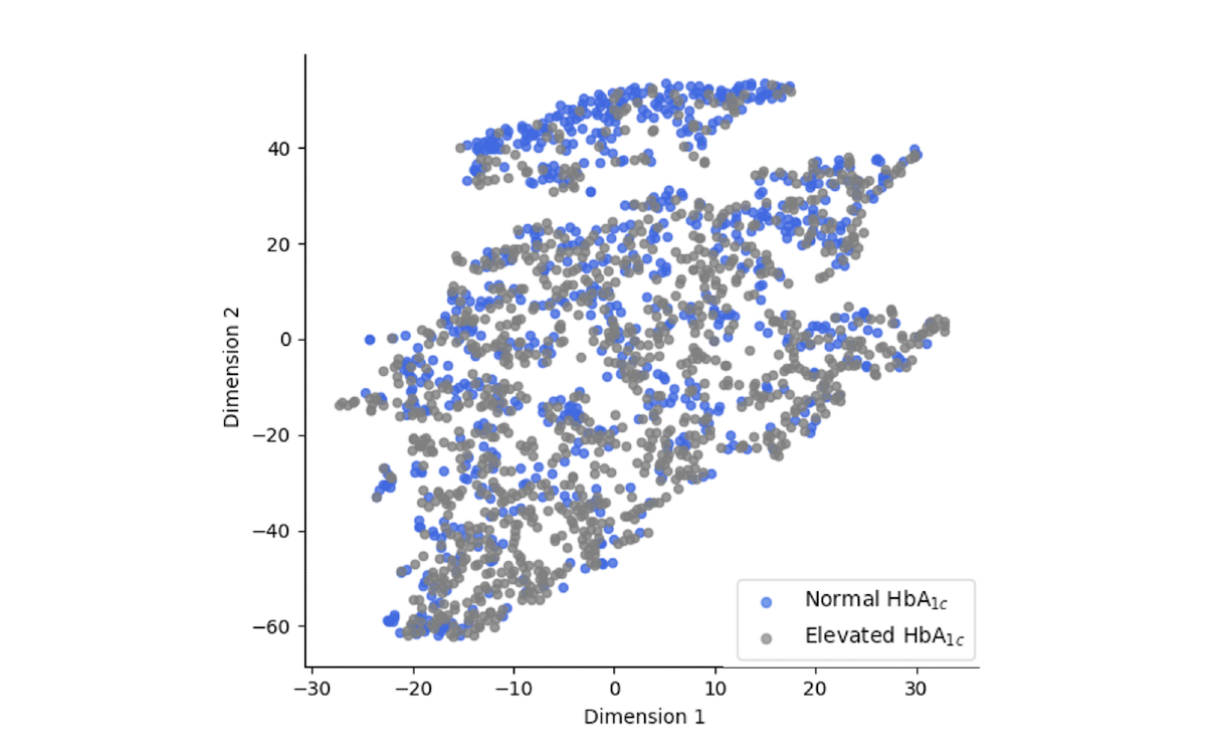
Figure 10. Two-dimensional visualization using t-distributed stochastic neighbor embedding for a randomly selected subset of the data. HbA 1c : glycated